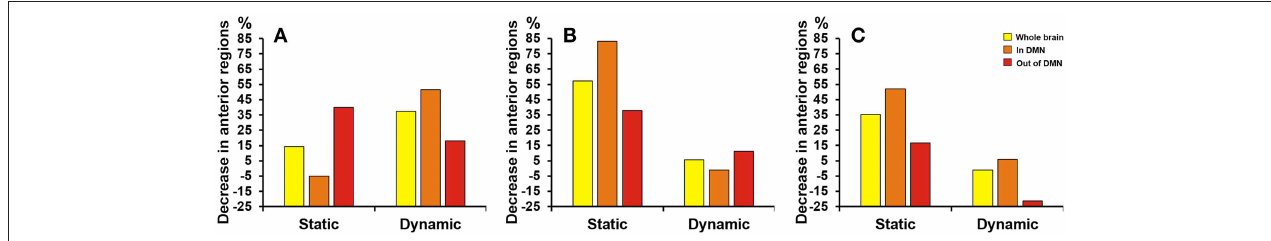
FIGURE 5 | Proportion of SCD group’s decrease in anterior cortical regions relative to NC group. The proportion of anterior regions revealed by static and dynamic functional connectivity in NC group minus the proportion in SCD group from the three levels: whole brain (yellow), in DMN (orange) and out of DMN (red). (A) The absolute threshold (correlation efficient r = 0.2). (B) The proportional threshold (sparsity = 0.2). (C) The proportional threshold (sparsity =